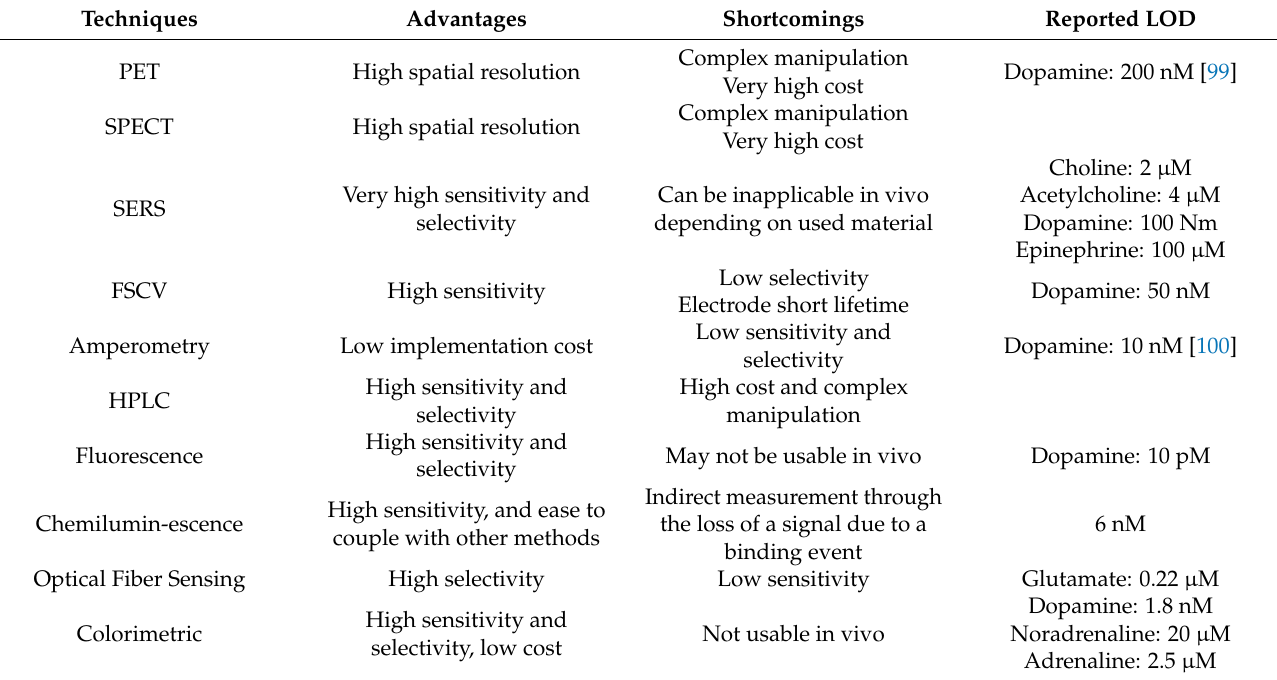
Table 1. Summary of neurotransmitter detection techniques.